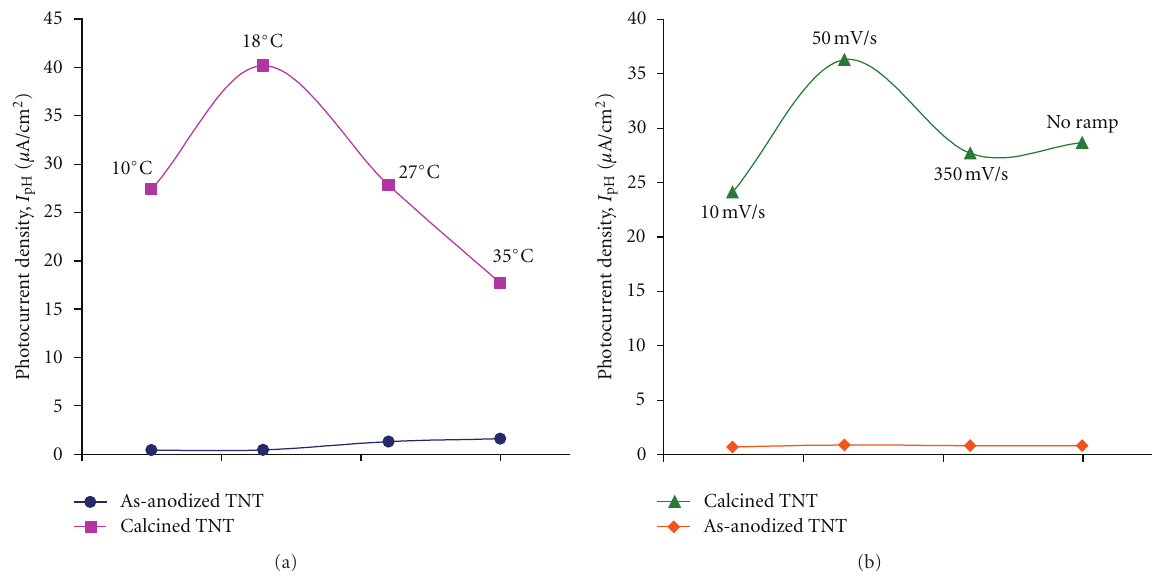
Figure 7: Comparison of photocurrent density at 1.0V (versus Ag/AgCl) of as-anodized and calcined TNTs prepared in pH 4 electrolytes (a) at di ff erent electrolyte temperatures and (b) using di ff erent voltage ramps prior to constant voltage of 20V. All the photocurrent measurements were obtained using 10 ppm methyl orange solution from 300 W halogen lamp at scan rate of 20mV/s.